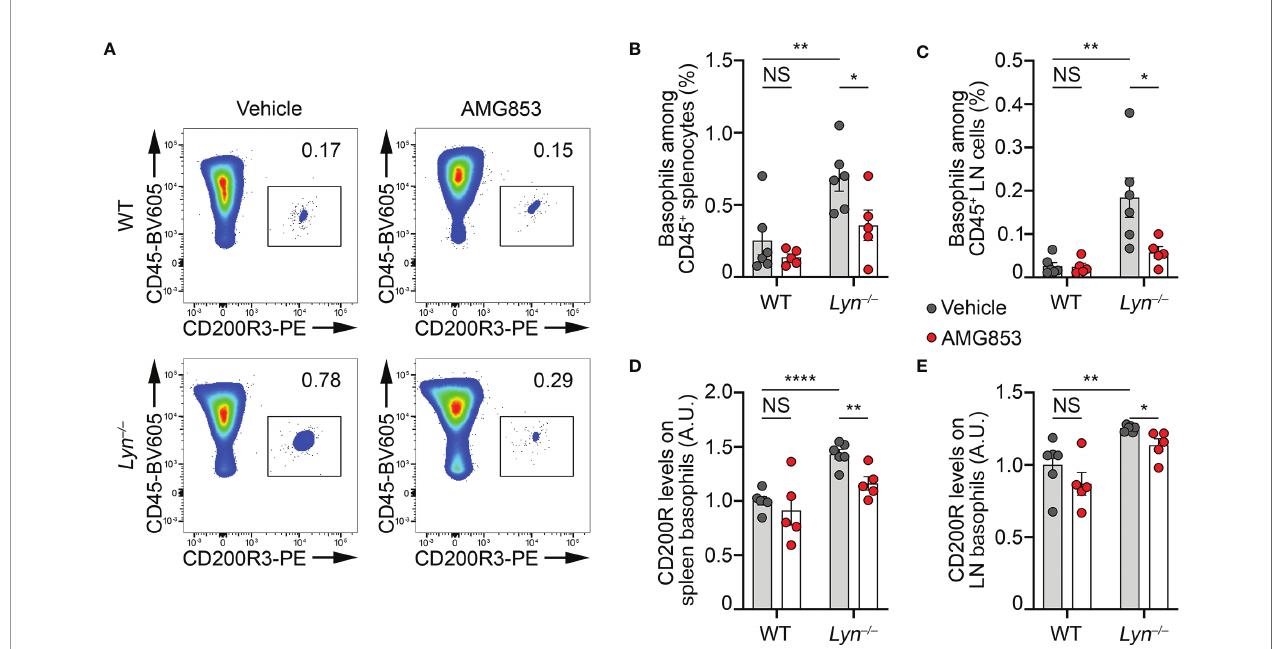
FIGURE 2 | AMG853 dampens the accumulation and activation of basophils in secondary lymphoid organs from Lyn − / − mice. Aged (40 – 50 weeks) wild-type (WT) and Lyn − / − female mice were treated for 10 days by oral gavage with AMG853 ( n = 5 per genotype, red fi lled circles ) or vehicle (10% EtOH in tap water; n = 6 per genotype, gray fi lled circles ). Basophil recruitment in the spleen (A, B) and peripheral lymph nodes (LNs) (C) was assessed by fl ow cytometry, as exempli fi ed in (A) and described in Materials and methods . Basophil activation was assessed by measuring the expression levels of CD200R by fl ow cytometry. The ratio of the geometric mean fl uorescence intensity (gMFI) of CD200R signal to the isotype control gMFI was normalized to the mean of the values from WT animals treated with vehicle in each experiment and expressed in arbitrary units (a.u.). Basophil activation was assessed in the spleen (D) and LNs (E) . Results were from three independent experiments. Individual values are indicated inside bars representing the mean ± SEM. Statistical analysis used unpaired Student ’ s t-tests between the indicated groups. NS p > 0.05; * p < 0.05; ** p < 0.01; **** p <